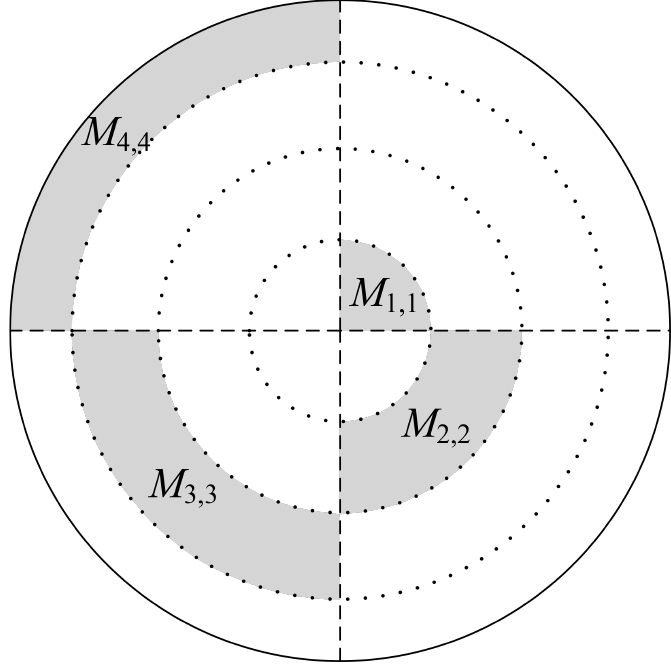
Figure 2. Primary divisions of